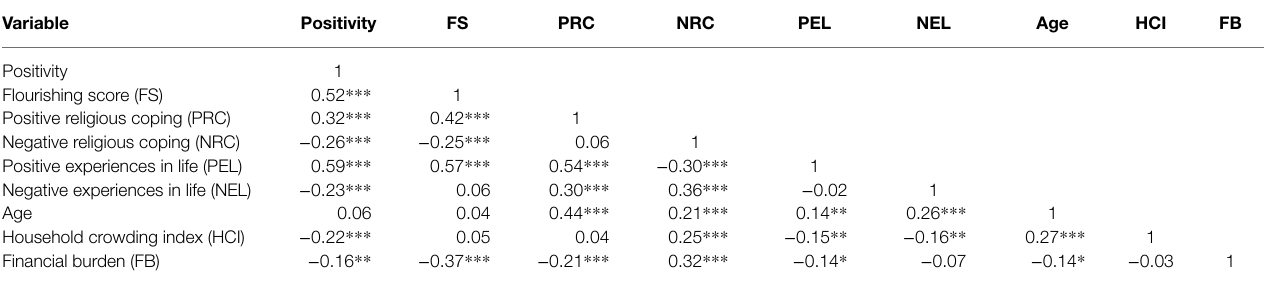
TABLE 3 | Correlations of the continuous variables with positivity. Variable